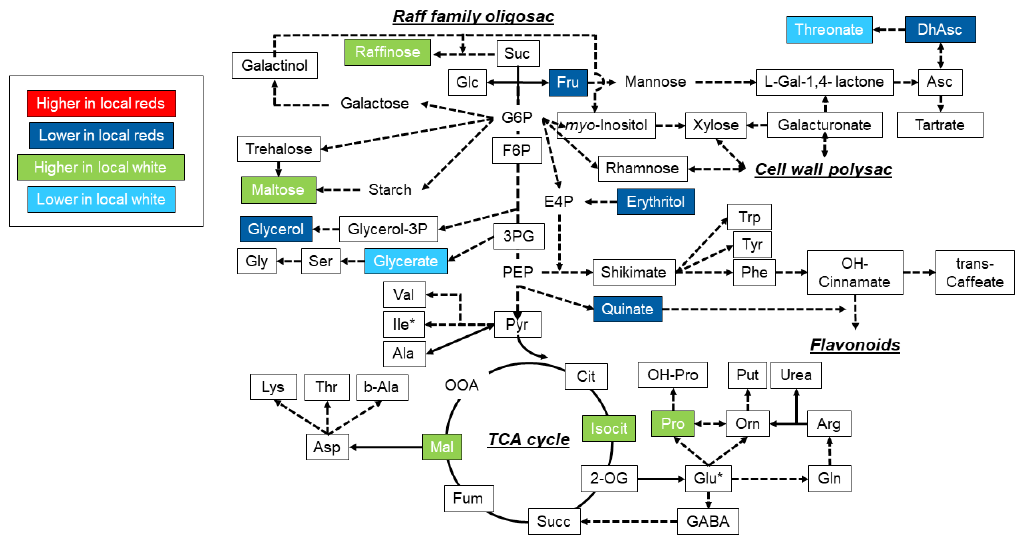
Figure 5. Metabolic model showing di ff erences in the levels of leaf primary metabolites between widespread and local white cultivars under water deficit stress (WDS). Metabolites highlighted are those showing significantly ( p < 0.05) higher or lower levels in local red (red or dark blue) and local white (green or light blue) cultivars as compared to their corresponding widespread ones. Data used was taken from Table S3. For the metabolite abbreviations see Figure 3.